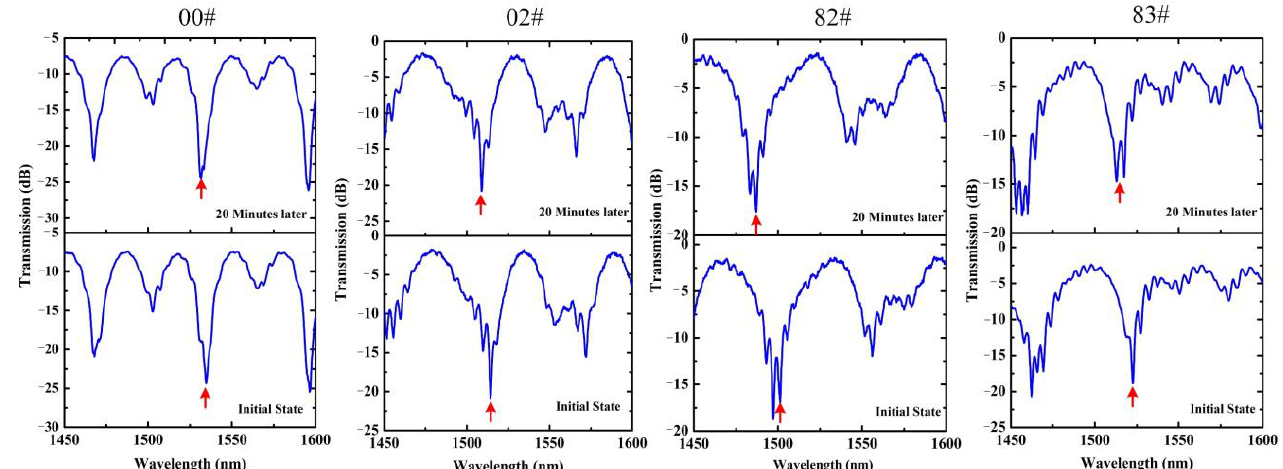
Figure 7. Transmission spectra evolution of grease sample 00#, 02#, 82# and 83# at coarse vacuum of ~20 Pa, and the diameter of the sensors used in the measurement process is 3.0 m.